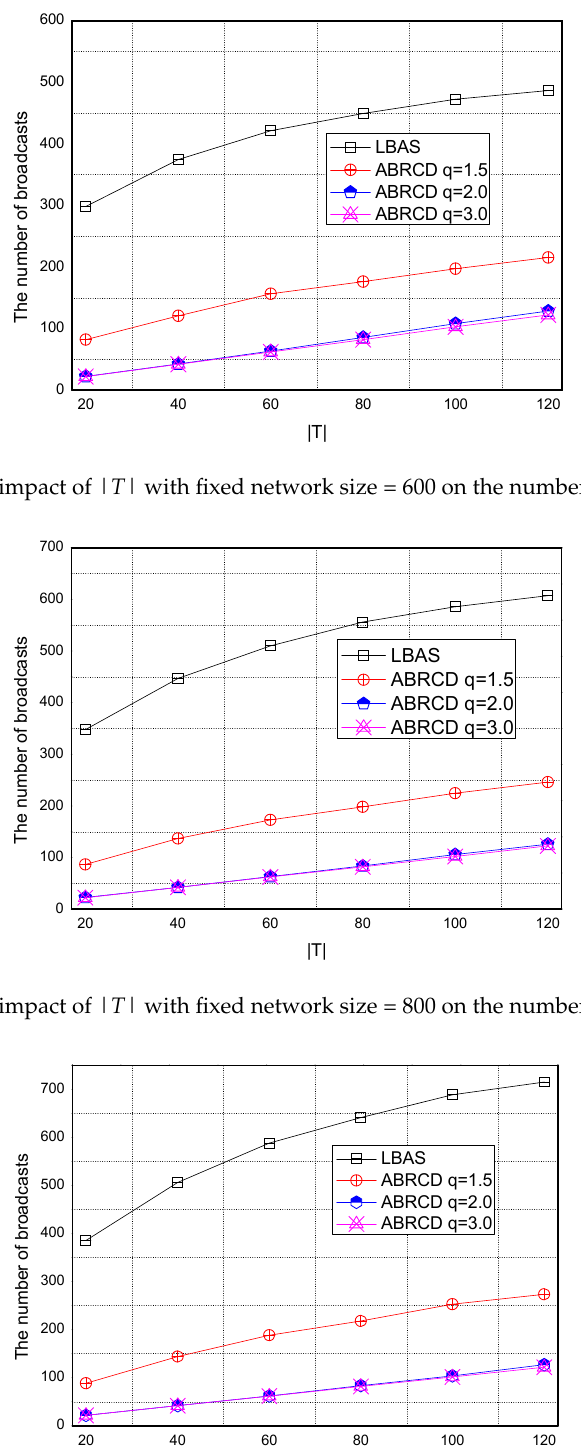
Figure 32. The impact of network size with fixed | T | = 20 on the number of broadcasts.